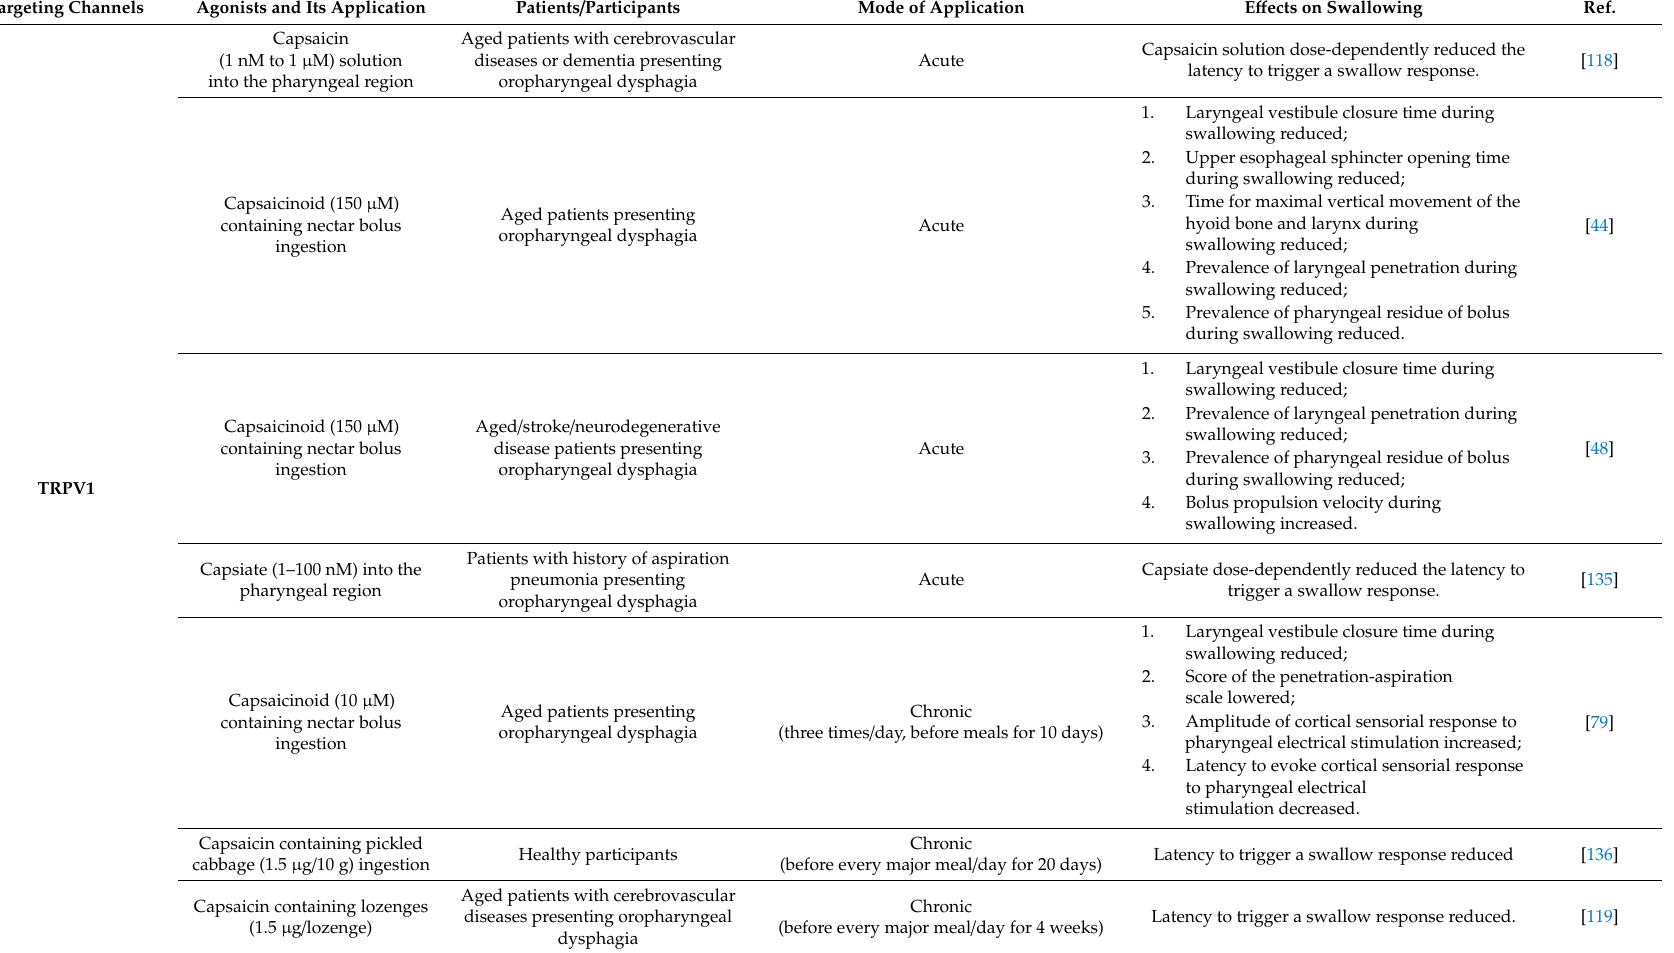
Table 3. Human studies investigating the e ff ects of targeting chemosensory ion channels on swallowing. Targeting